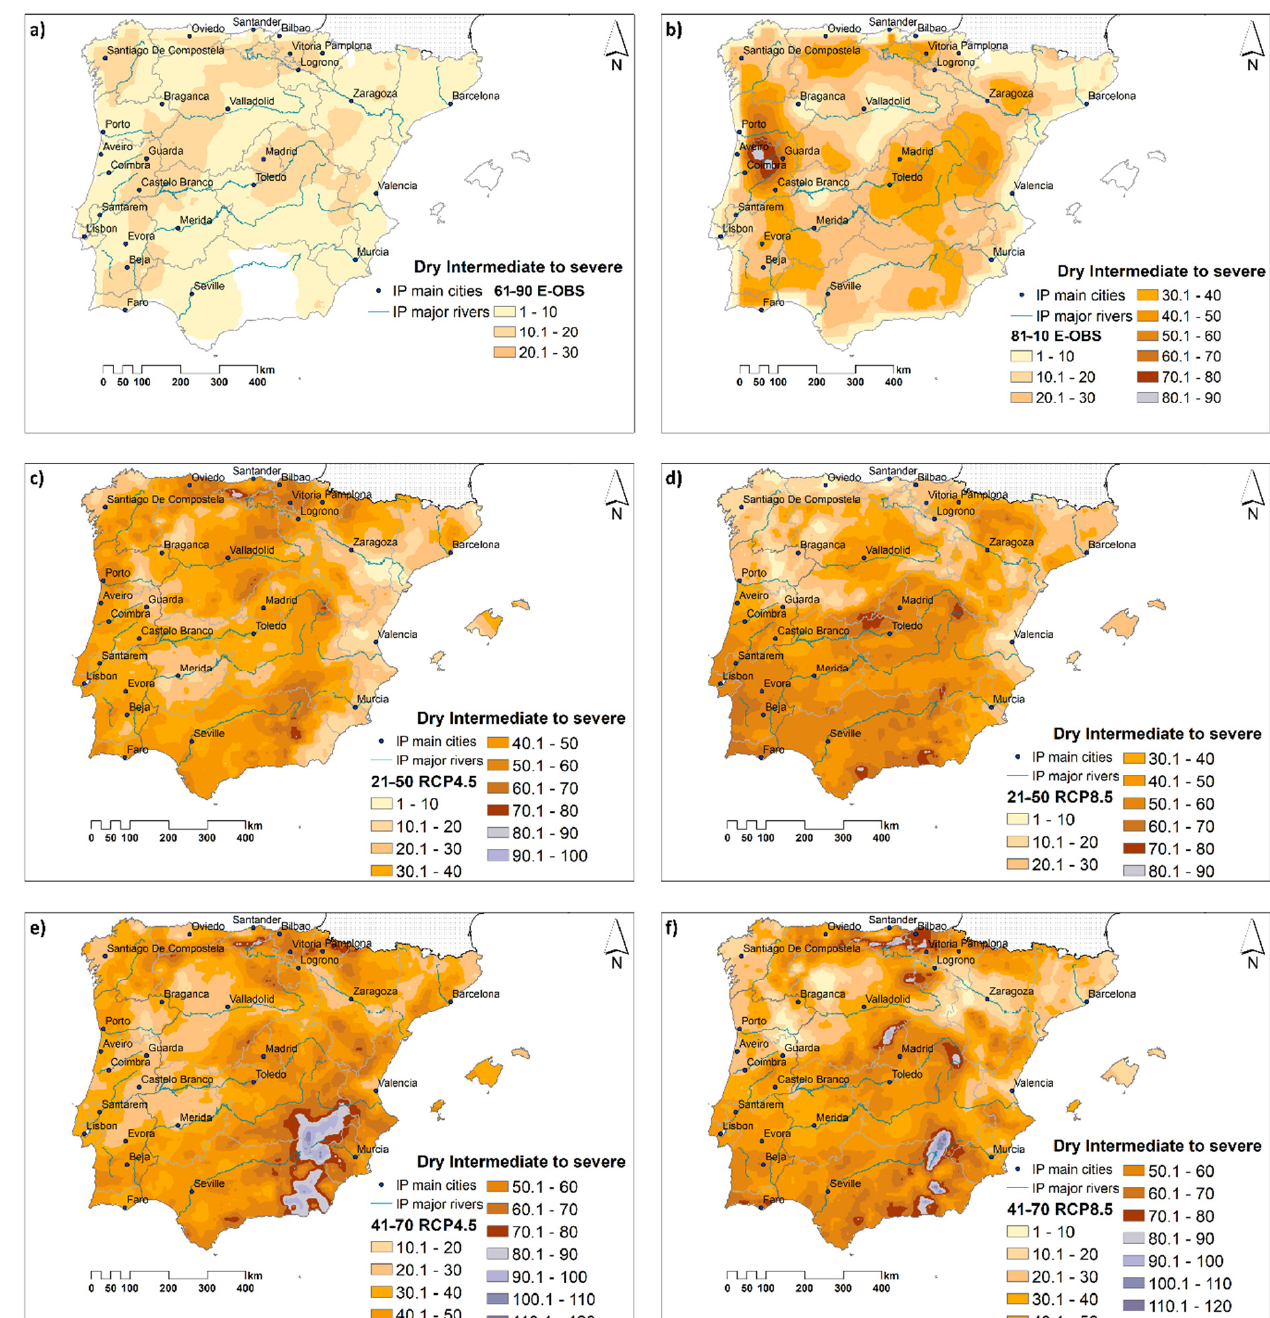
Figure 5. Duration in months of 12m-WASP intermediate-to-severe dry events in IP for the periods ( a ) 1961–1990; ( b ) 1981–2010; ( c , d ) 2021–2050; ( e , f ) 2041–2070 under RCP4.5 (left) and RCP8.5 (right) (Note: NUTS 2 in grey contours).